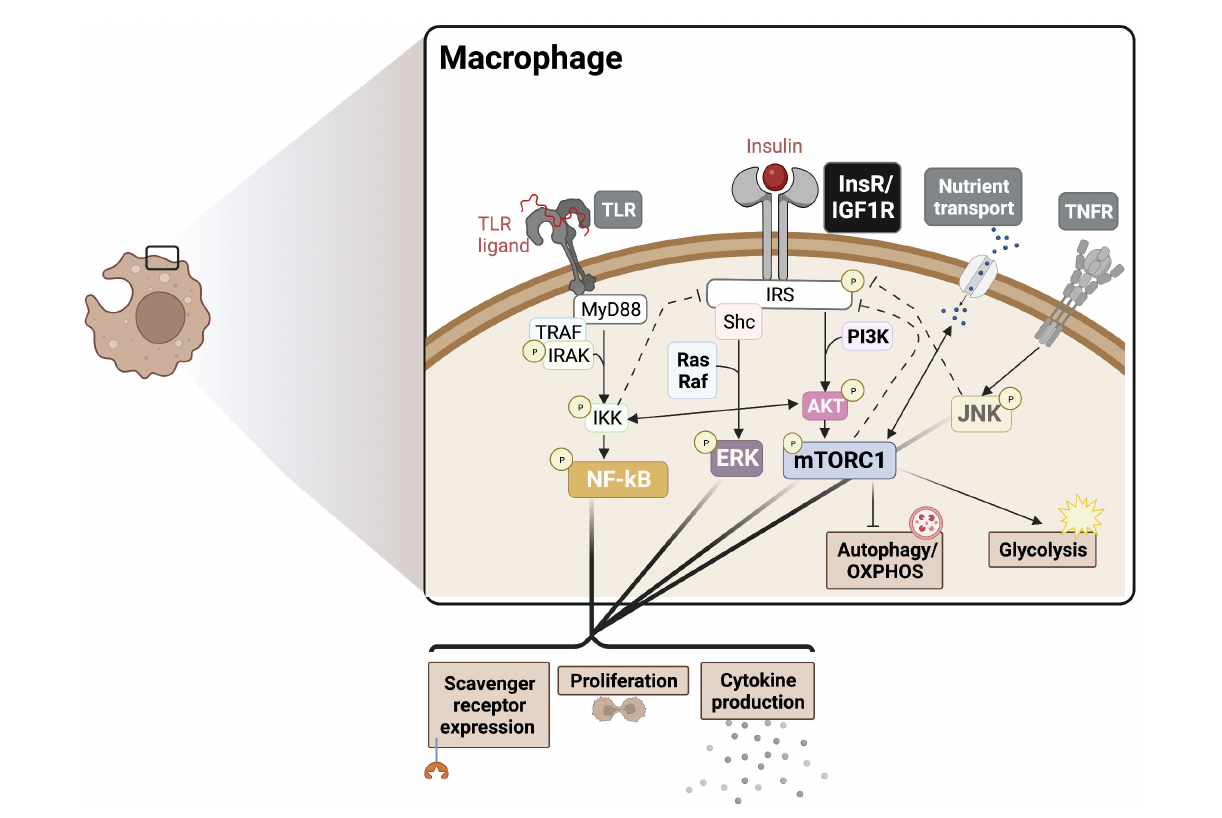
FIGURE 1 Insulin crosstalk with immune signalling pathways in macrophages. PAMPs/DAMPs trigger surface and endosomal TLRs, signalling largely via MyD88 to NF-kB to drive cytokine production, proliferation, and scavenger receptor expression. InsR/IGF1R signals through MAPK and Akt/mTORC1 to boost cytokine production and proliferation, supporting the TLR response. These signalling events also drive downstream metabolic programming to support the redox balance and energetic demands, promoting an in fl ammatory phenotype. Activation of mTORC1 also blocks autophagy, which provides substrates for OXPHOS. Various points of crosstalk exist between InsR, PRRs, cytokine receptor, and nutrient sensing responses can also drive insulin resistance via negative feedback mechanisms (dotted lines), for example in cases of chronic hyperinsulinemia. The degree to which each intersecting pathway is stimulated likely determines the nature of the pleiotropic phenotypes seen in IR macrophages. PAMPs, Pathogen- associated molecular patters; DAMPs, Damage-associated molecular patterns; OXPHOS, Oxidative phosphorylation; PRR, pattern recognition receptor; TLR, Toll-like receptor; MyD88, Myeloid differentiation primary response 88; NF-kB, Nuclear factor kappa B; InsR, Insulin receptor; IGF1R, Insulin-like growth factor 1 receptor; ERK, extracellular regulated kinase; mTORC1, mammalian target of rapamycin complex